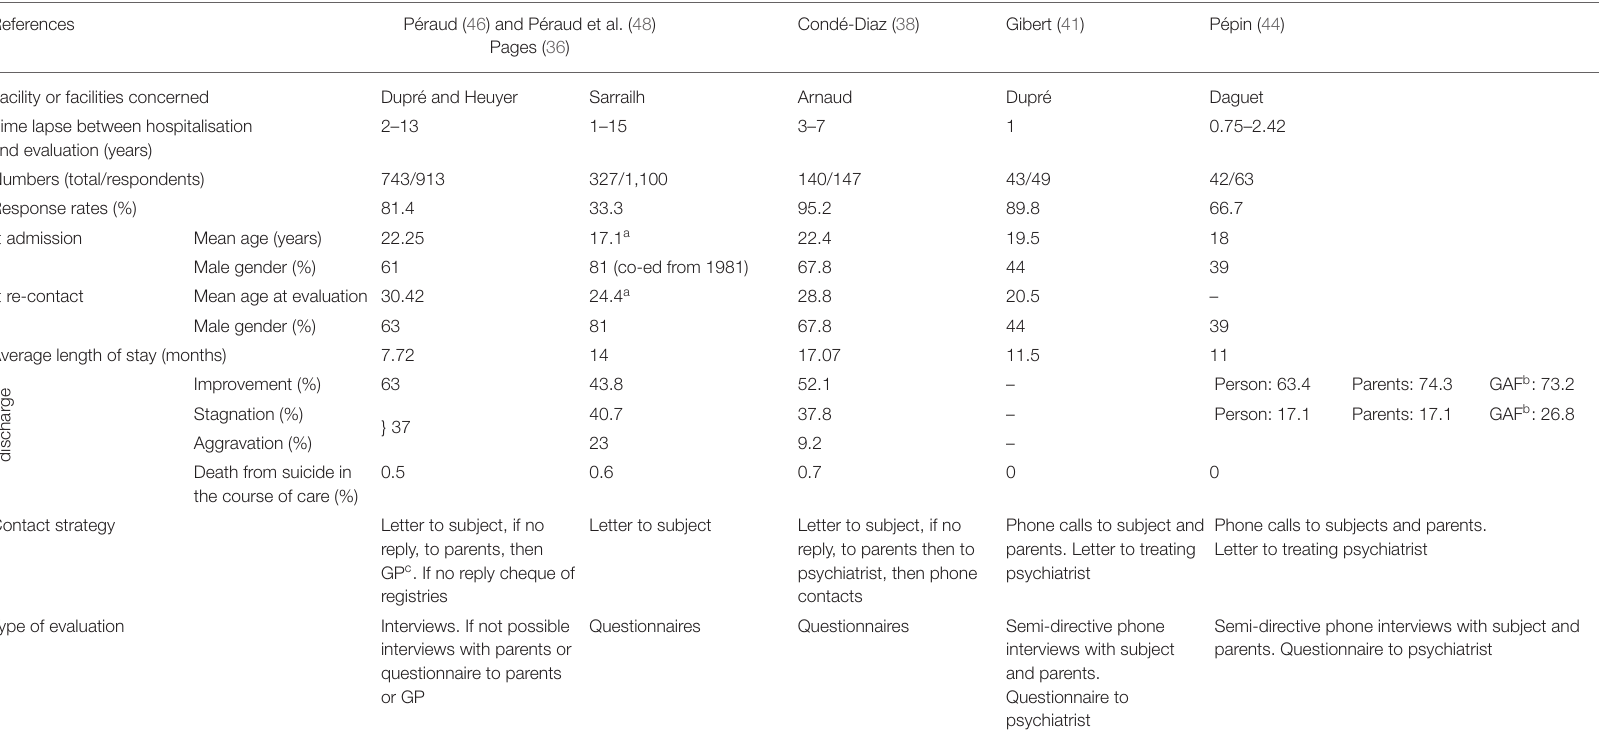
TABLE 3 | Description des jeunes et de leur devenir dans les études évaluant le devenir à long terme après une hospitalisation